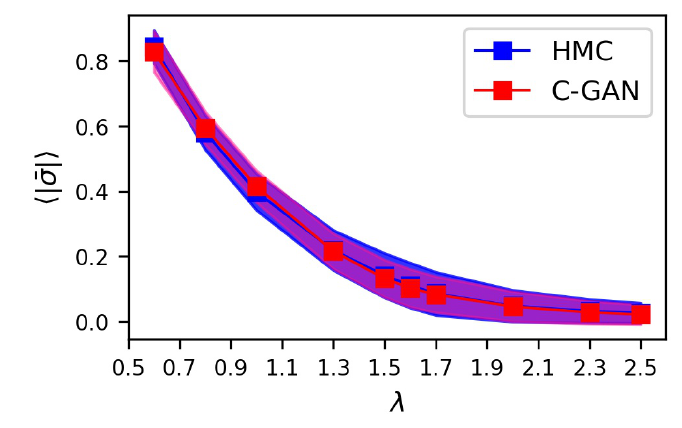
Figure 9: Mean 〈| ¯ σ |〉 and standard deviation for Λ obtained via HMC and